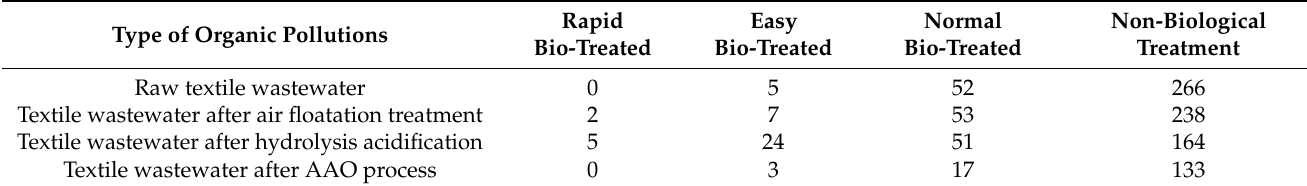
Table 3. Degradability of organic matter (calculated as COD) in wastewater among treatment